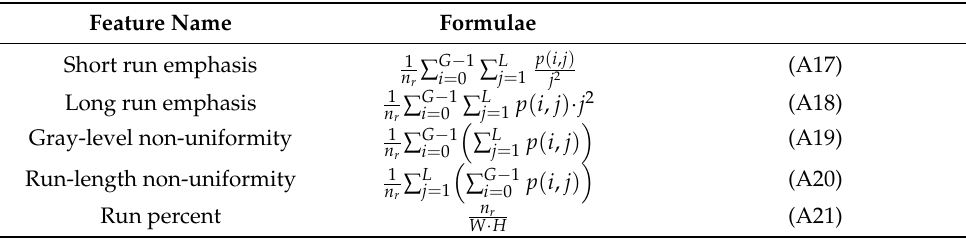
Table A3. Formulae to calculate run-length matrix features from the gray-scale